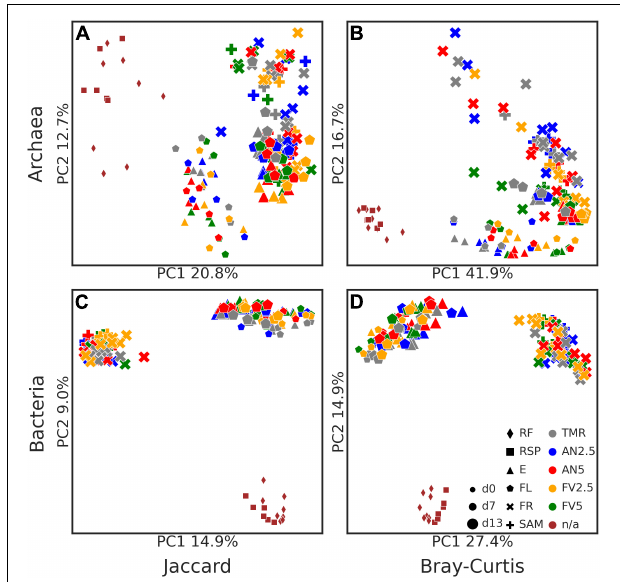
FIGURE 4 | Principal coordinates analysis (PCoA) plots of beta diversity metrics. Jaccard (A,C) and Bray–Curtis (B,D) distances are plotted for archaea (A,B) and bacteria (C,D) . Points are sized by the sampling day (days 0–13), shaped by the sample type, and colored by treatments [as stated in the legend on subplot (D) ]. Label “n/a” in the legend means no treatment was